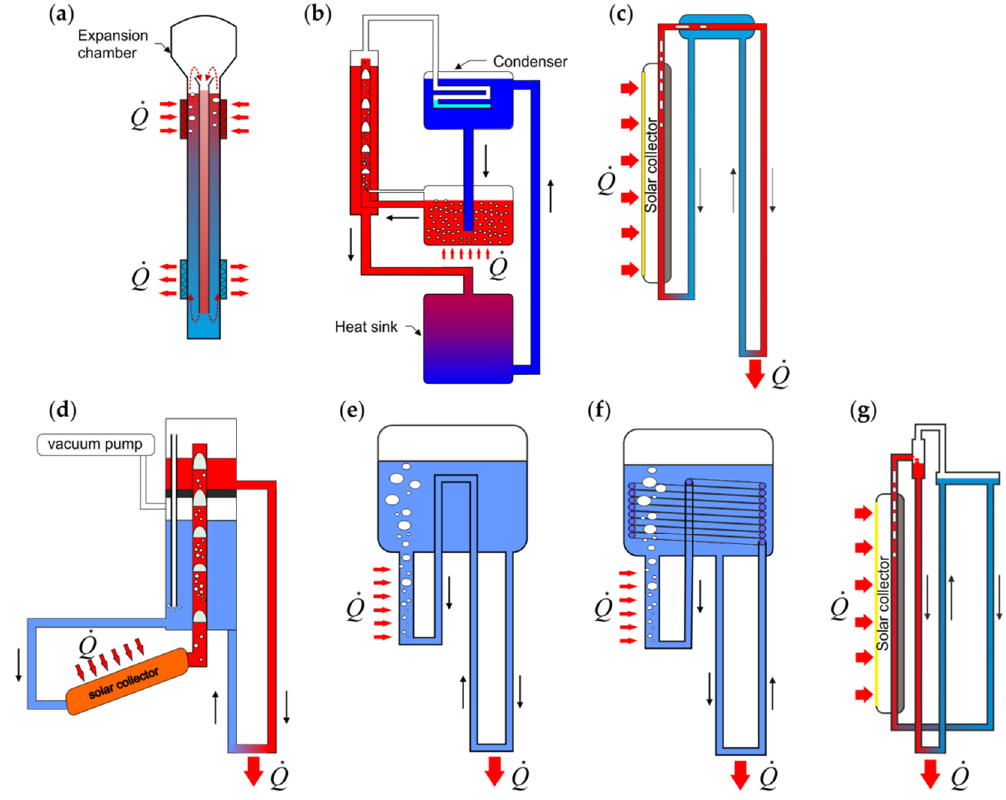
Figure 2. Diagrams of devices with a bubble pump for transporting heat downward (The figure is